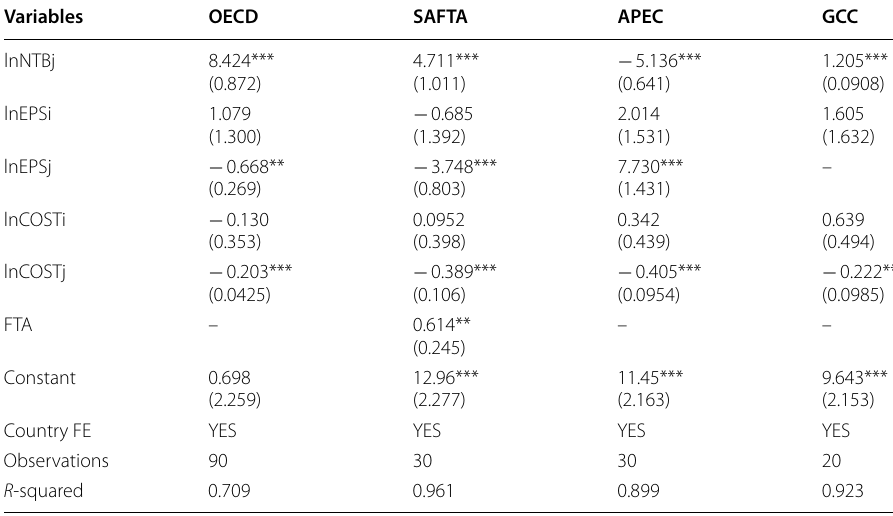
Table 8 Regression results, robustness checks; dependent variable: lnEXPij